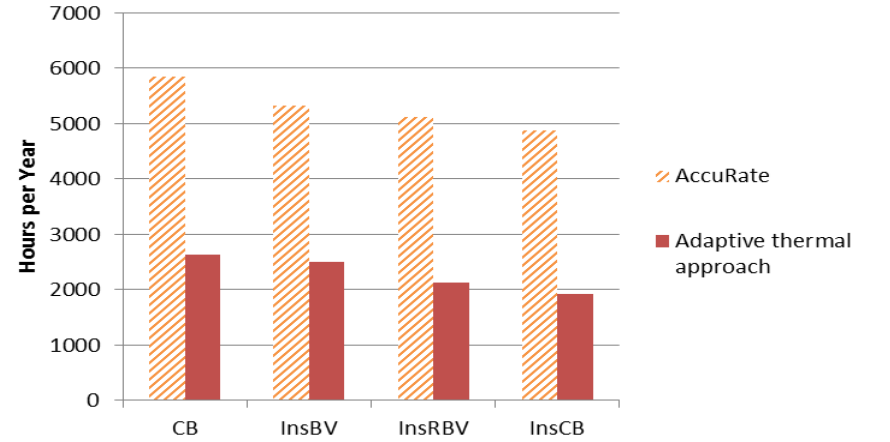
Fig. 9. Number of hours required either heating or cooling for AccuRate and the adaptive